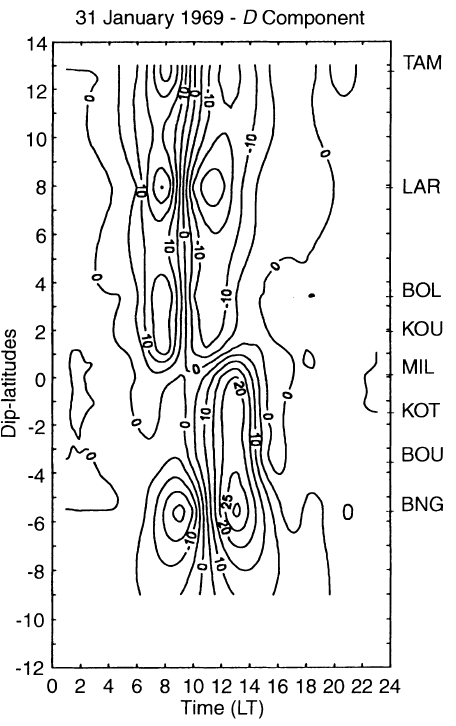
Fig. 8. Contour map of the magnetic field daily variation D obtained by Fambitakoye and Mayaud (1976a) from data recorded along a 17 (cid:176) E meridian profile in Central Africa on 31